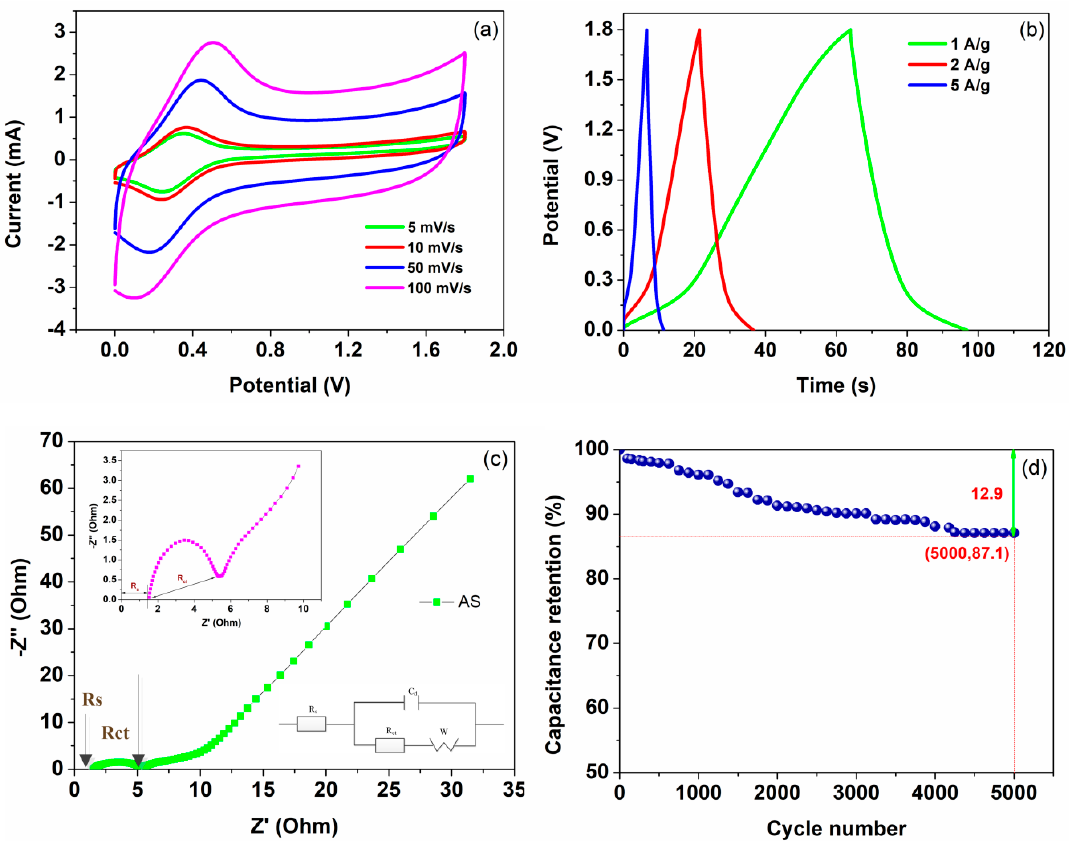
Figure 5. ( a ) CV curves of the AS at different scanning rates. ( b ) GCD curves of the AS at different current densities. ( c ) Nyquist plots of the AS. ( d ) Stability study for the AS. Table 1. The specific capacitance, energy density and power density of the AS at di ff erent current densities.